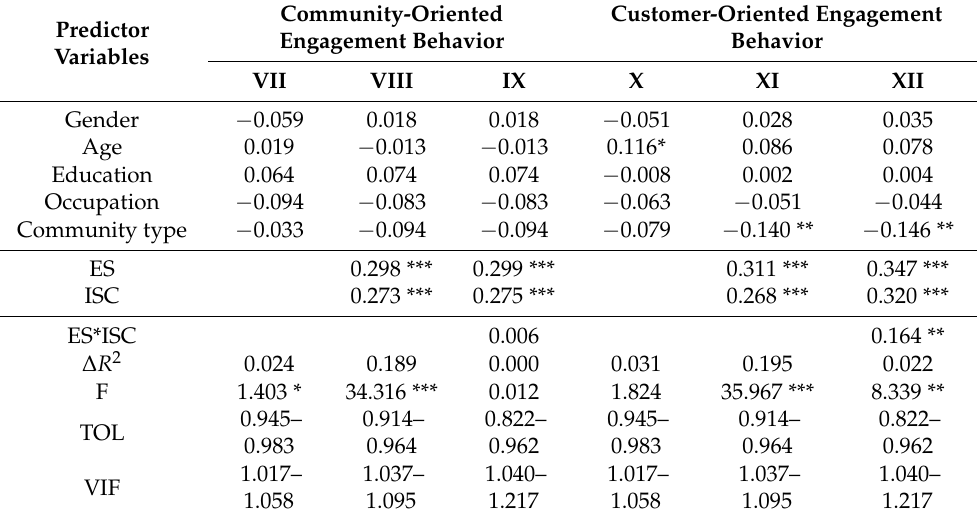
Table 6. The result of the moderation of interdependent self-construal in the relationship between emotional support and the two dimensions of